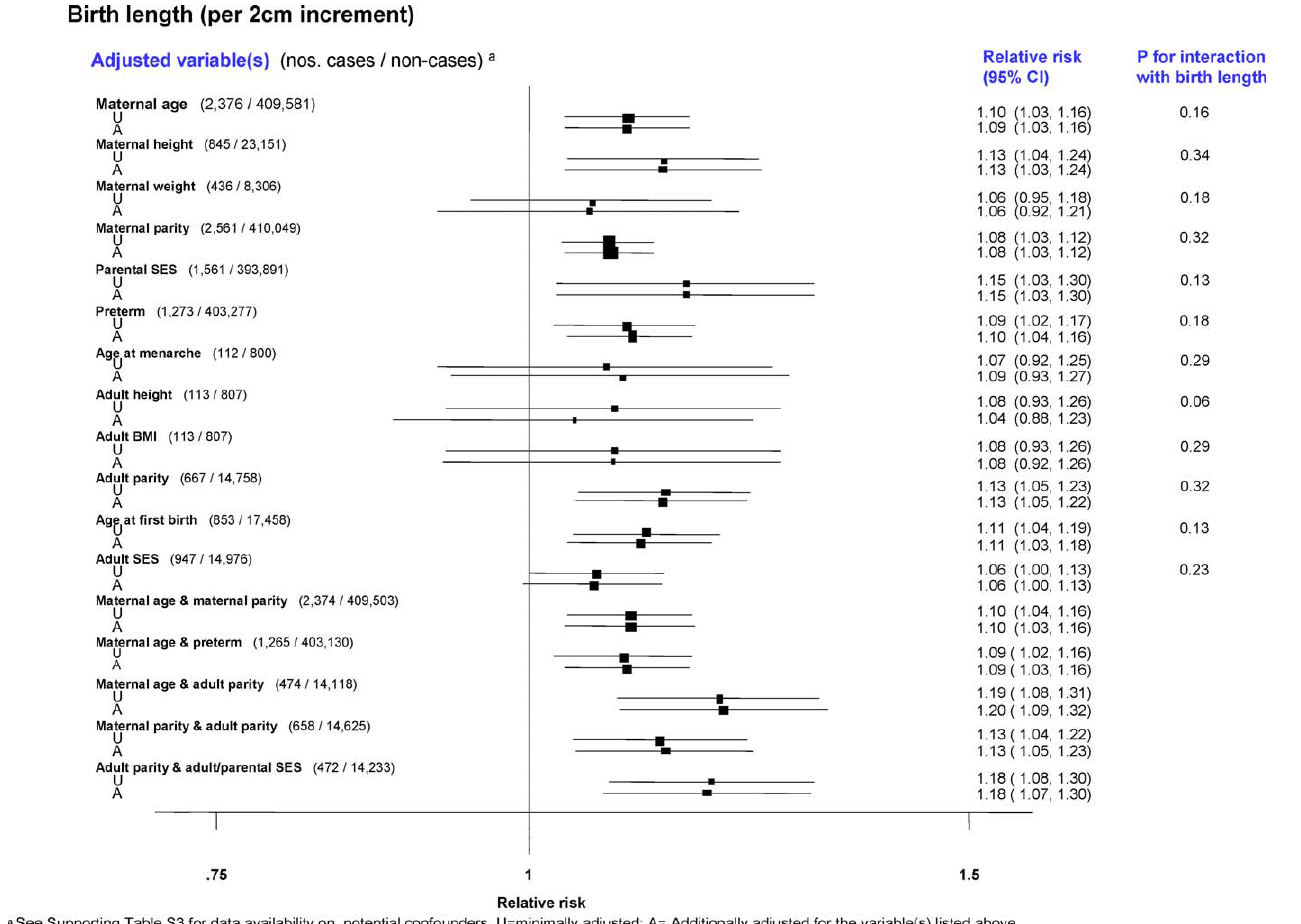
Figure 6. Pooled Breast Cancer RRs, Minimally Adjusted and Further Adjusted for Various Potential Confounding Factors in Relation to Continuous Birth Length (Restricted to Singleton Studies Based on Birth Records) Adjustments for maternal age (continuous), maternal height (continuous), maternal weight (continuous), maternal parity (categorical: 0, 1, 2, (cid:2) 3), parental SES (study-specific categories: paternal SES for Medical Research Council National Survey of Health and Development [MRC NSHD]; maternal SES for Saint Olav’s University Hospital Birth Cohort [SOUHCB], Trondheim & Bergen Population-based Case-Control Study [TBPCCS] and Swedish study on Pre-Natal Factors and Breast Cancer [SPNFBC]; and parental/paternal occupation for Carolina Breast Cancer Study [CBCS]), preterm (binary), age at menarche (categorical: , 12 y, 12.0–12.9 y, (cid:2) 13 y), adult height (continuous), adult BMI (continuous), adult parity (categorical: 0, 1, 2, (cid:2) 3), age at first birth (categorical: nulliparous, , 20 y, 20–29 y, (cid:2) 30 y), and adult SES (study-specific categories: adult SES for MRC NSHD, Helsinki Birth Cohort